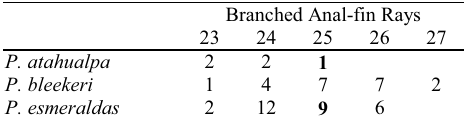
Table 24. Number of specimens of the species of Paracetopsis with cited number of branched anal-fin rays. Bold indicates value for holotype when examined.